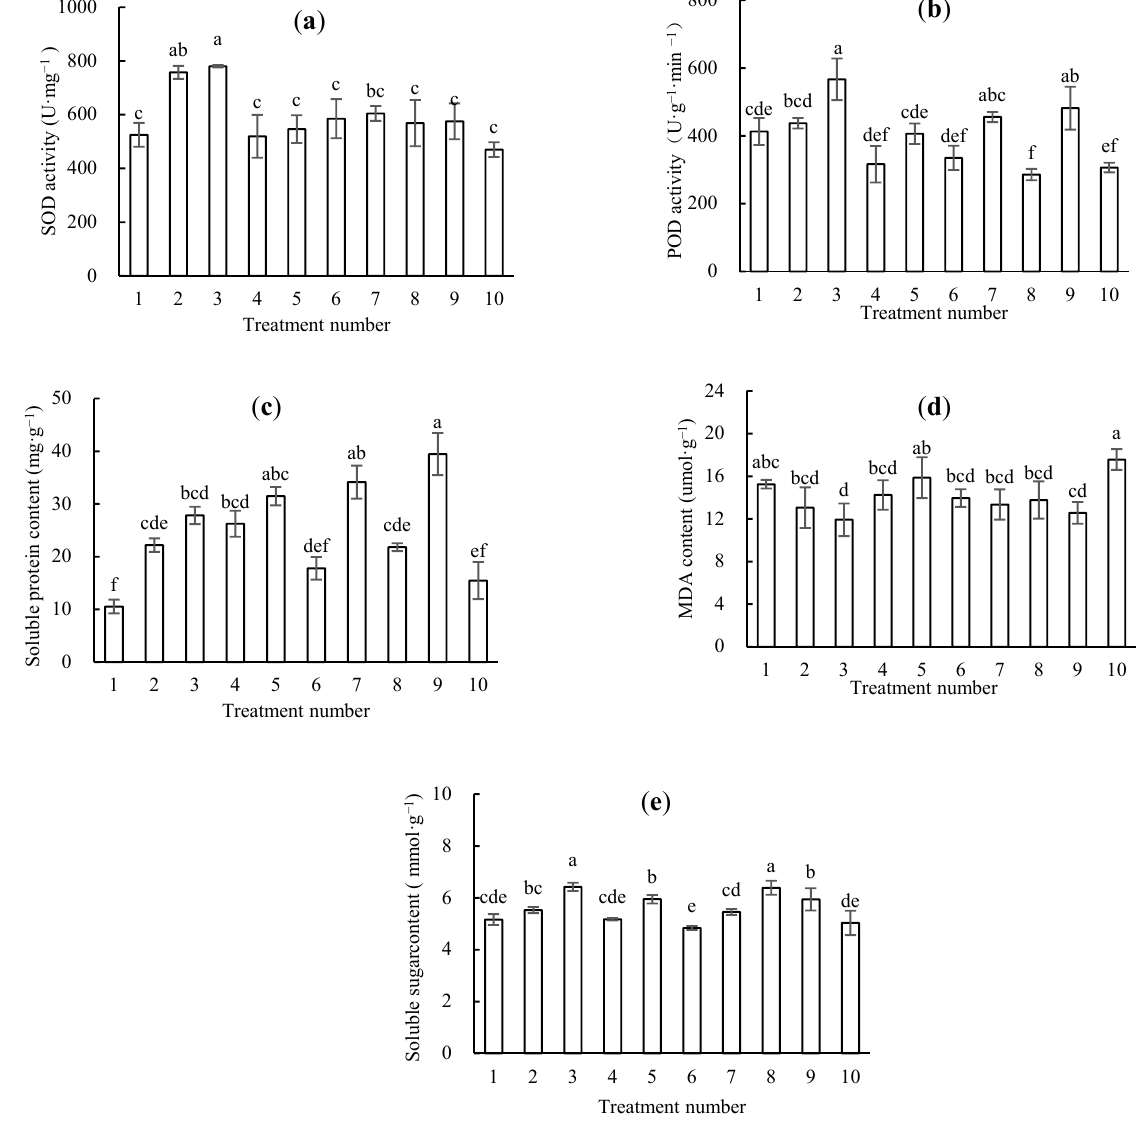
Figure 2. The effects of PGRs on SOD activity ( a ), POD activity ( b ), soluble protein ( c ), MDA content ( d ), and soluble sugar ( e ) of M. wufengensis .